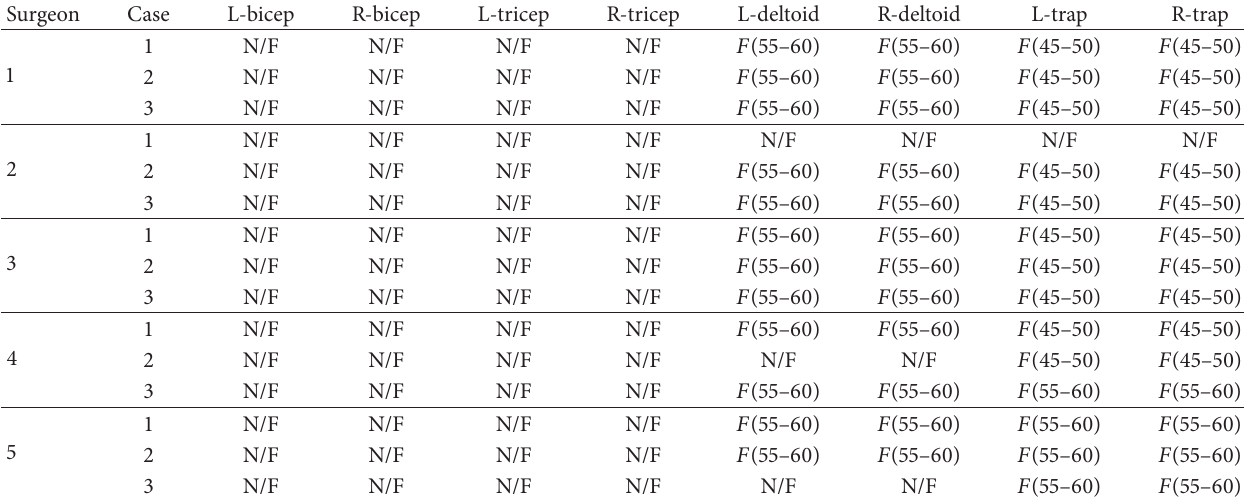
Table 2: Time-to-fatigue for all the muscle groups (minutes).